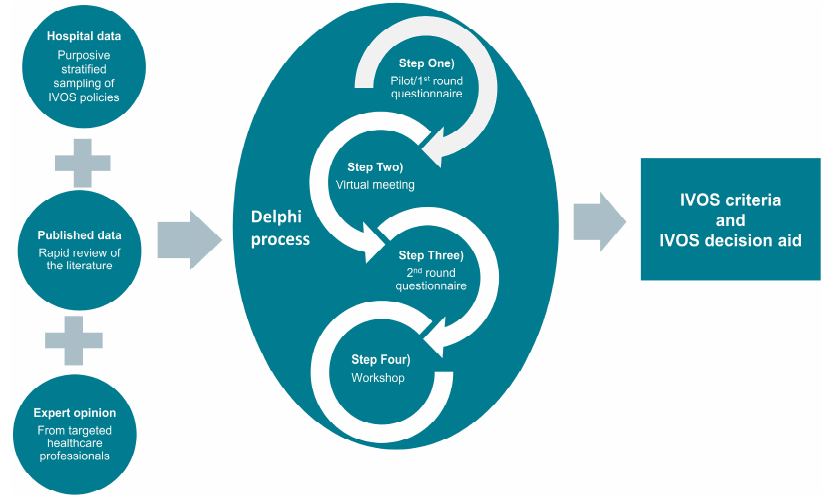
Figure 1. overview of the study . Figure 1. Overview of the